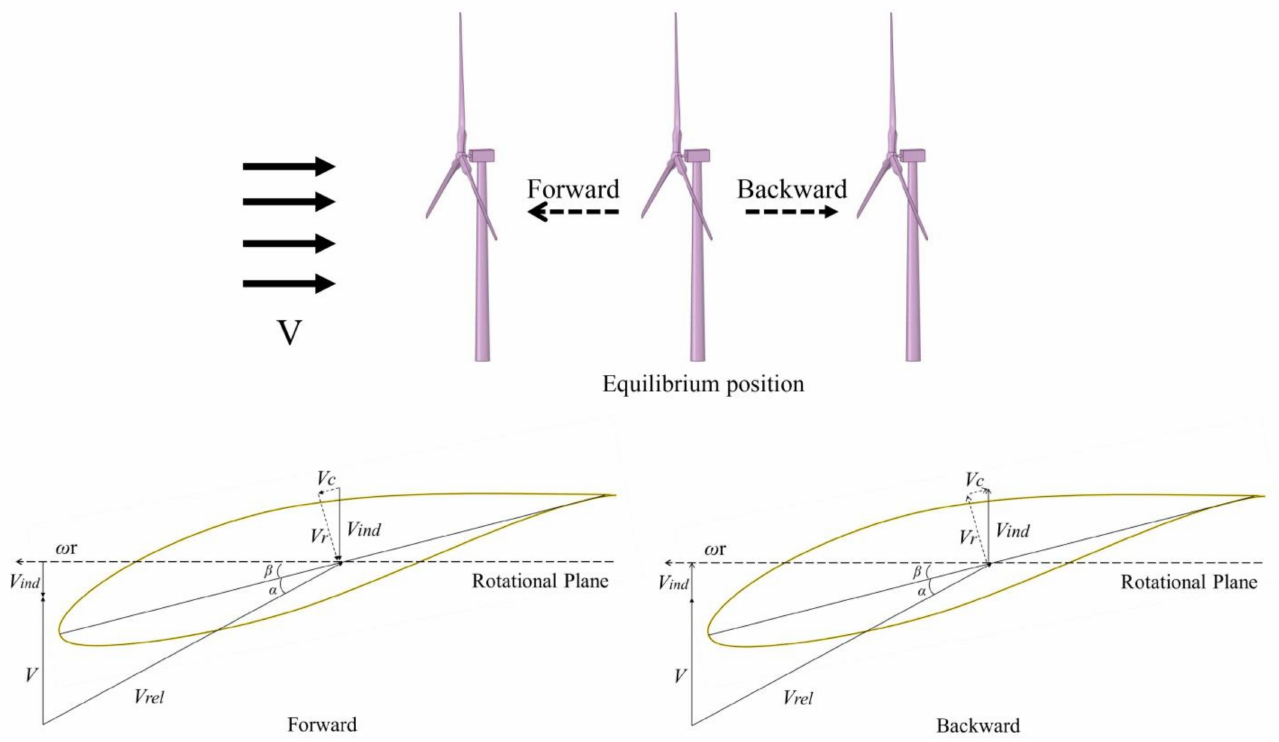
Figure 8. Schematic diagram of airfoil-induced velocity under surge